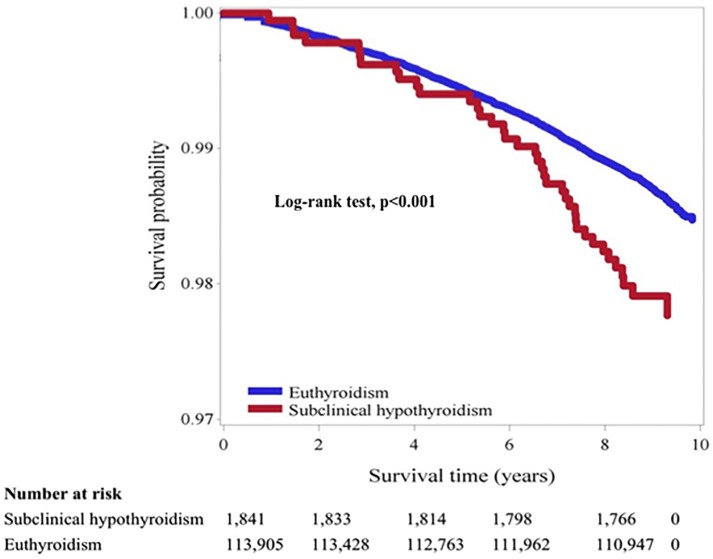
Comparison of cancer morality in subjects with subclinical hypothyroidism or euthyroidism.